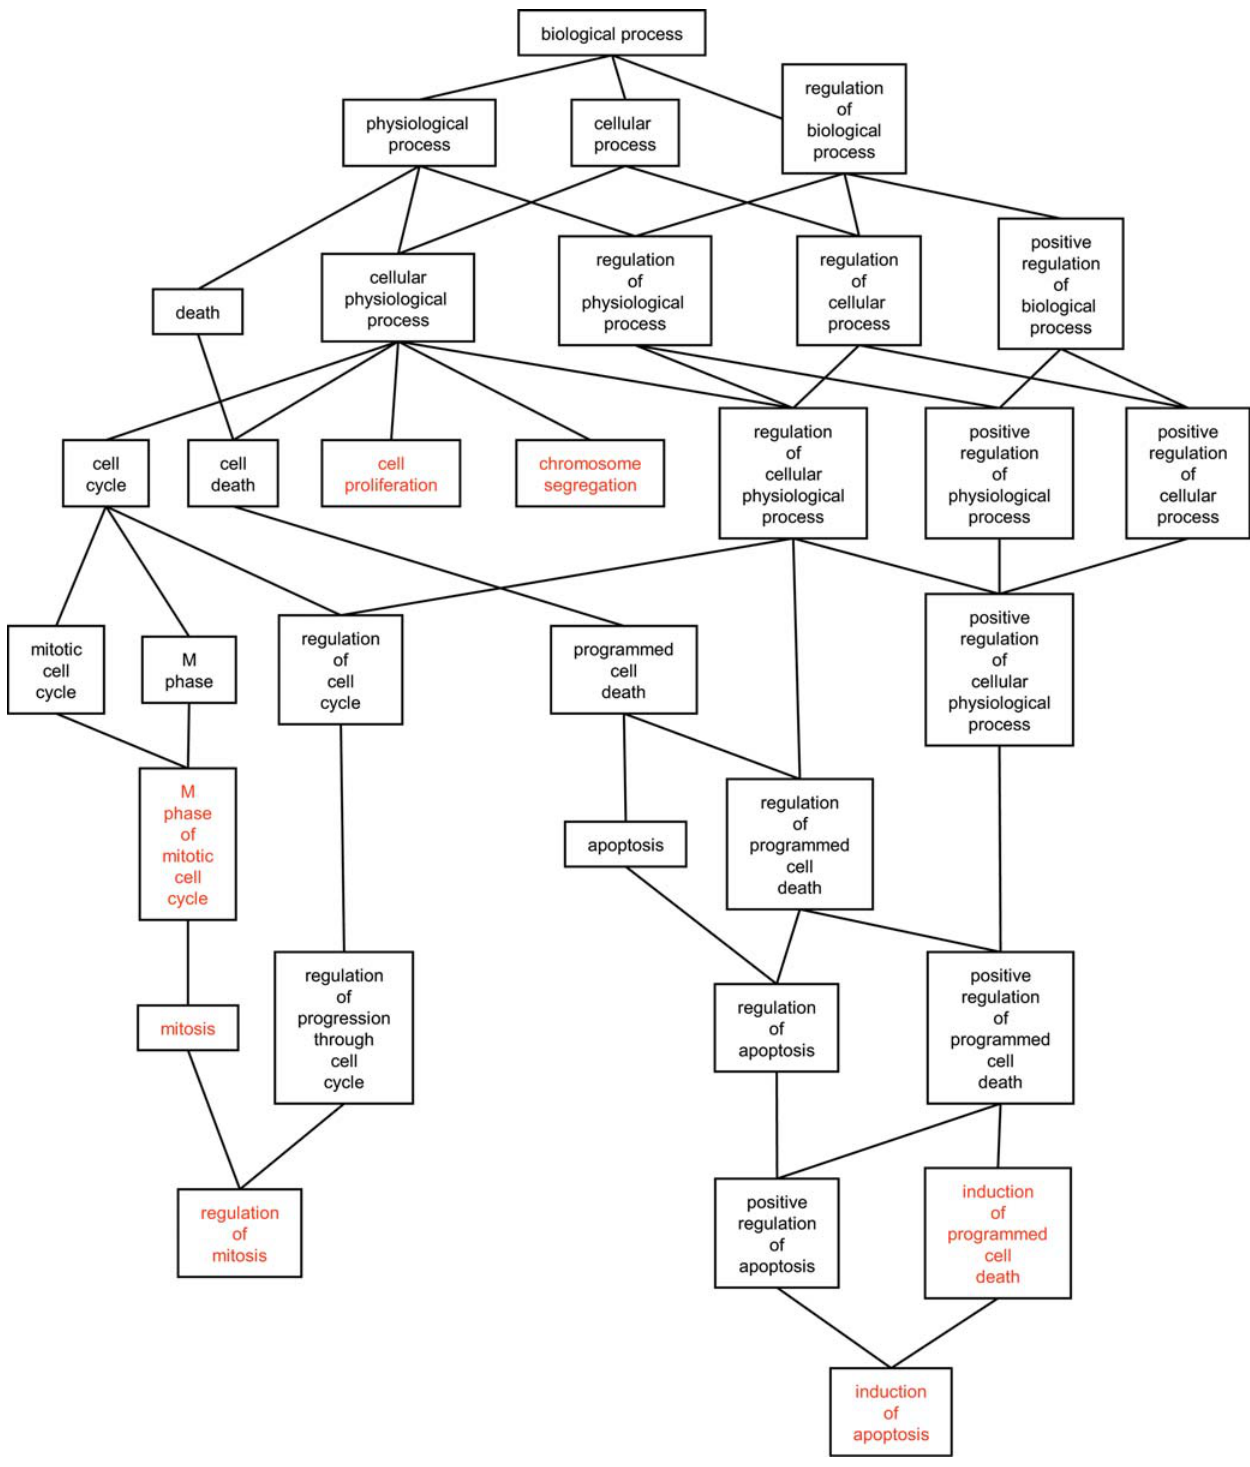
Figure 5. GO biological process terms over-represented among the set of genes with Made1 derived hsa-mir-548 target sites. The portion of the directed acyclic graph (DAG) containing all paths from the root biological process term to the over-represented functional category terms is shown. Over-represented functional categories are indicated in red. doi:10.1371/journal.pone.0000203.g005 Gene expression profiles for potential hsa-mir-548 targets were corresponding Symatlas expression data across 79 human tissues. taken from the Novartis Research Foundation’s Symatlas [34]. For The expression data were median and log normalized to yield the miRBase set, a total of 2,045 target genes were found with relative tissue-specific gene expression profiles, and these profiles